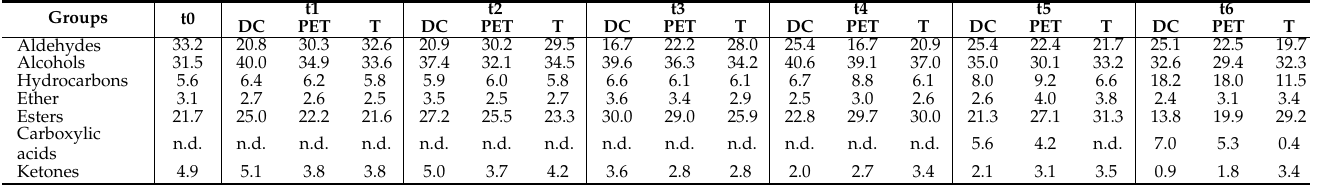
Table 2. Chemical distribution of VOCs of oils stored in different